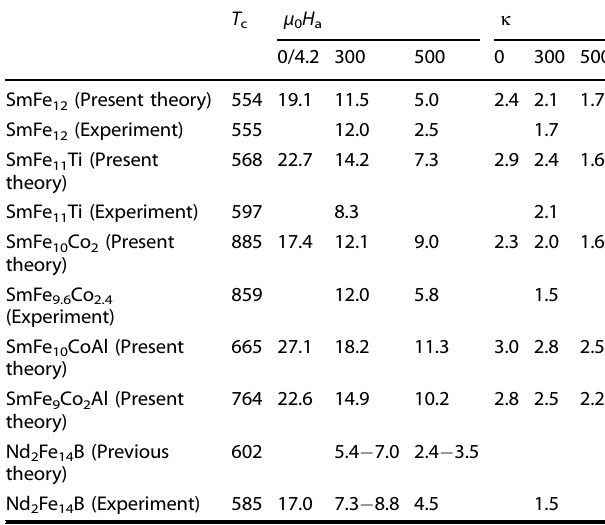
Table 3. Predicted Curie temperature T c (K), anisotropy fi eld μ 0 H a (T), and hardness parameter κ of SmFe 12 , SmFe 11 Ti, SmFe 10 Co 2 , SmFe 10 CoAl, and SmFe 9 Co 2 Al at 0, 300, and 500 K.